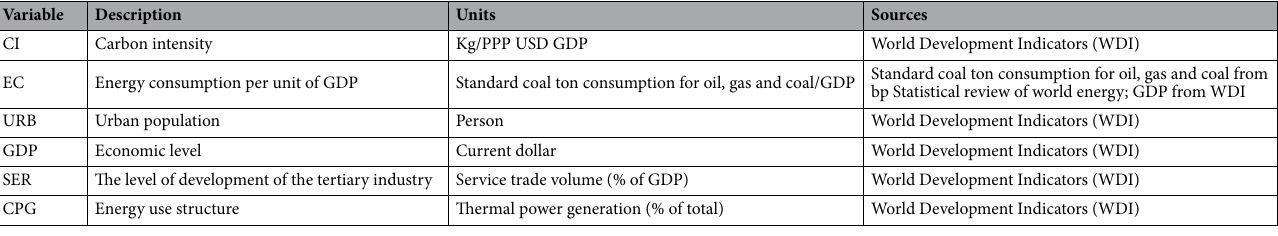
Table 2. The source of each